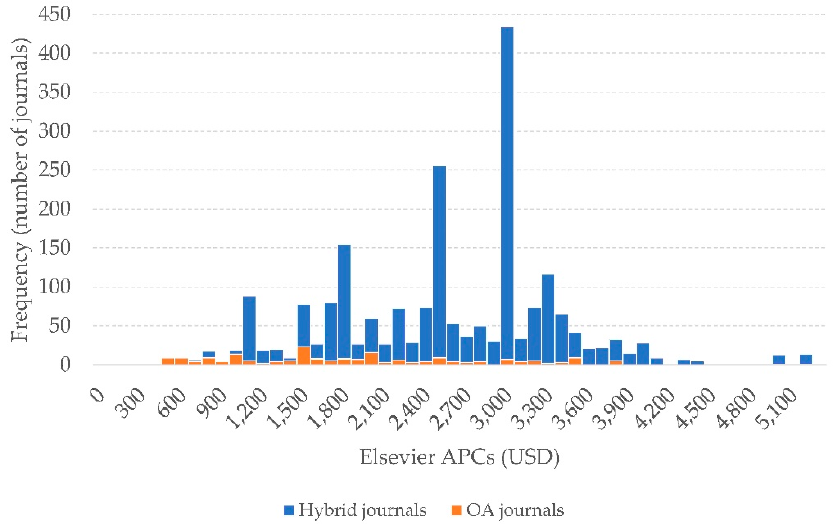
Figure 2. Frequency distribution of Elsevier’s article processing charges (APCs) (as of March 2019).